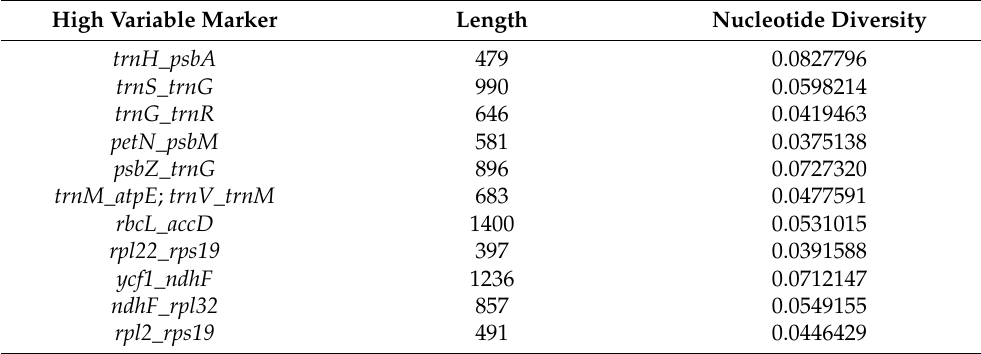
Table 6. Nine regions of highly variable sequences (Pi > 0.12) of Celastraceae species. High Variable Marker